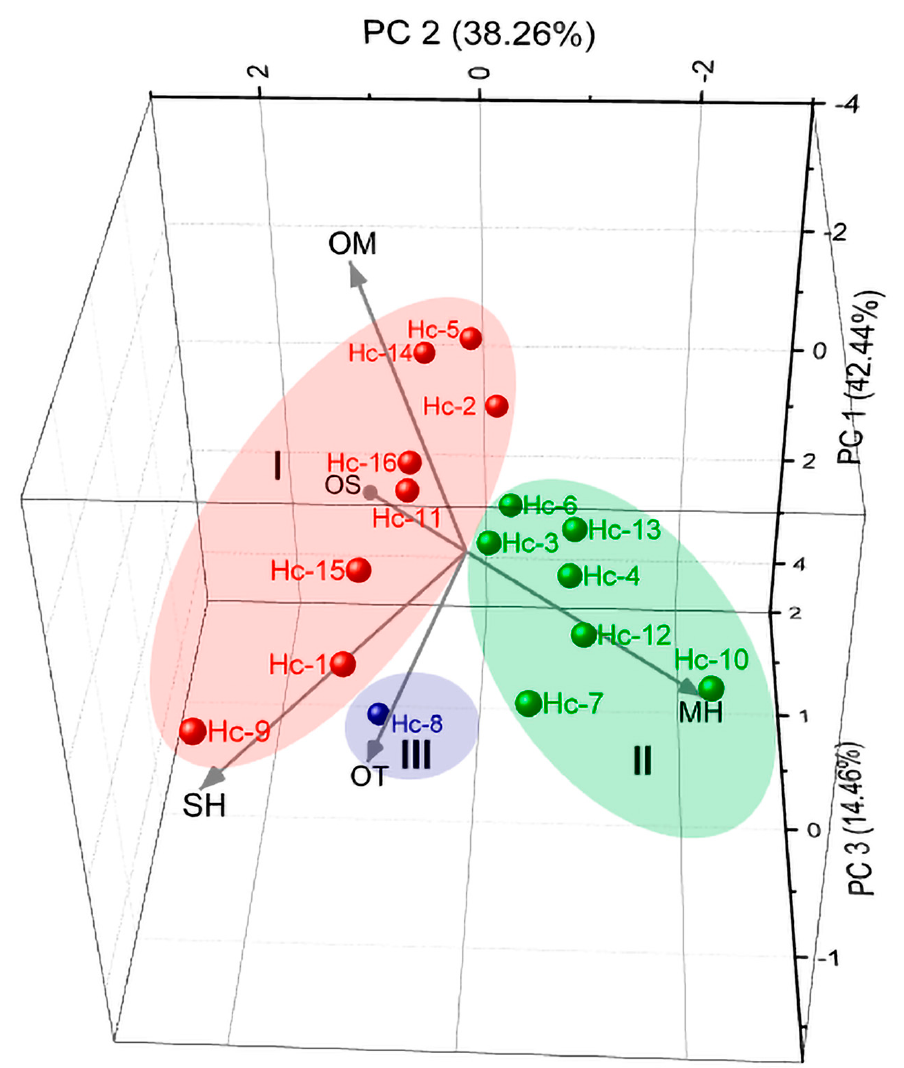
Figure 3. Principal Component Analysis of Hyptis crenata oil samples. Applying additional multivariate analyses in the heatmap analysis combined with hierarchical clustering analysis with the compound classes, the color pattern varied with color intensity and increased gradually, from lowest to the highest grade. The clustered heatmap (Figure 5) confirmed the above clustering results for HCA and